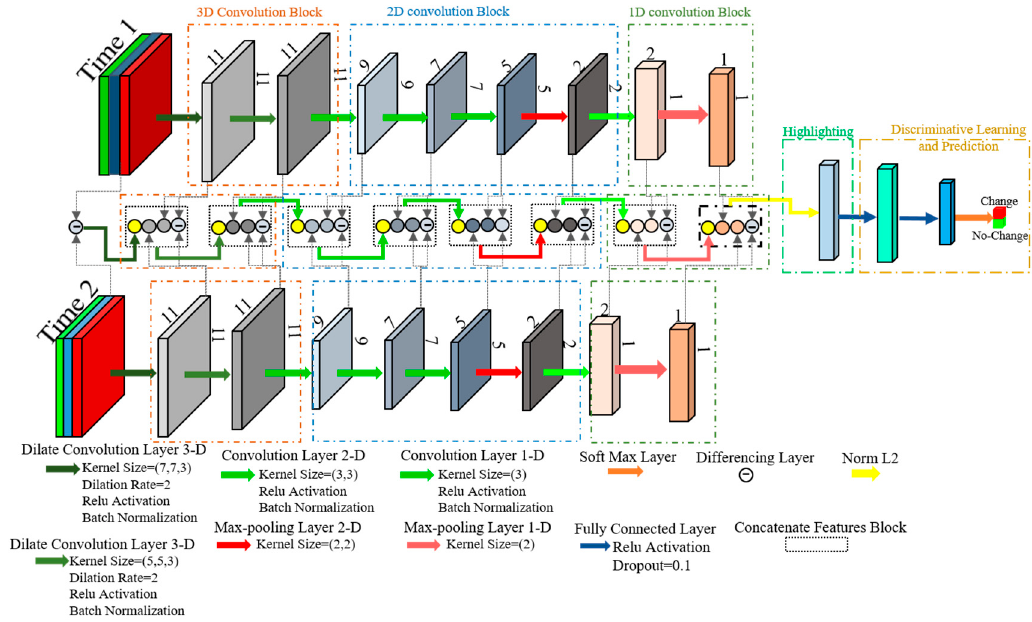
Figure 5. The proposed End-to-End convolutional neural network (CNN) architecture for CD of remote sensing datasets.